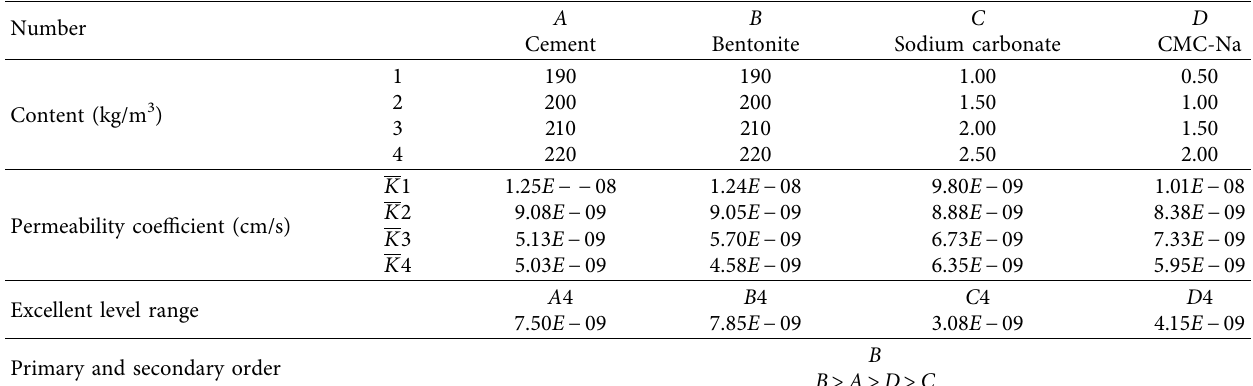
Table 4: Range analysis of 28-day permeability coefficient of samples.